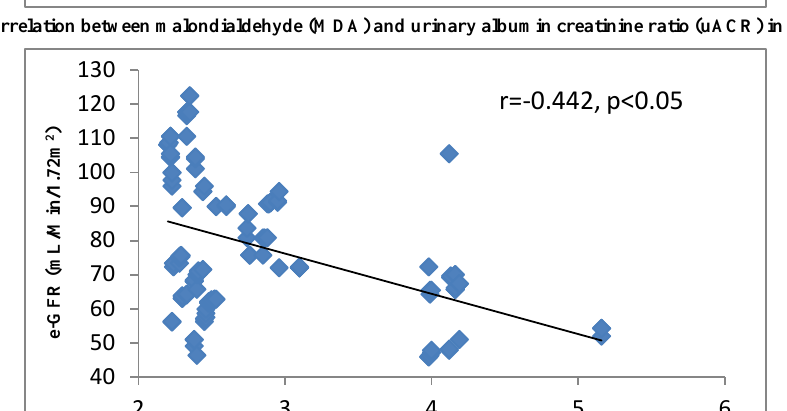
Fig. 2. Correlation between malondialdehyde (MDA) and urinary albumin creatinine ratio (uACR) in smokers.